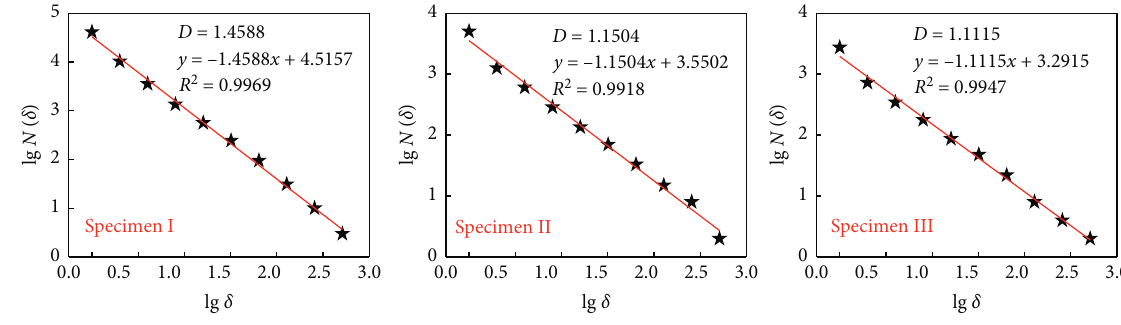
Figure 8: Calculation result of fractal dimension of